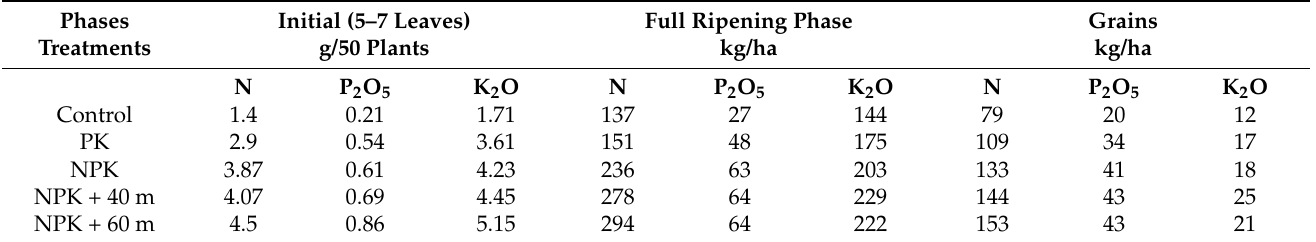
Table 6. Influence of mineral and organic fertilizers on the consumption of nutrients by maize plants.